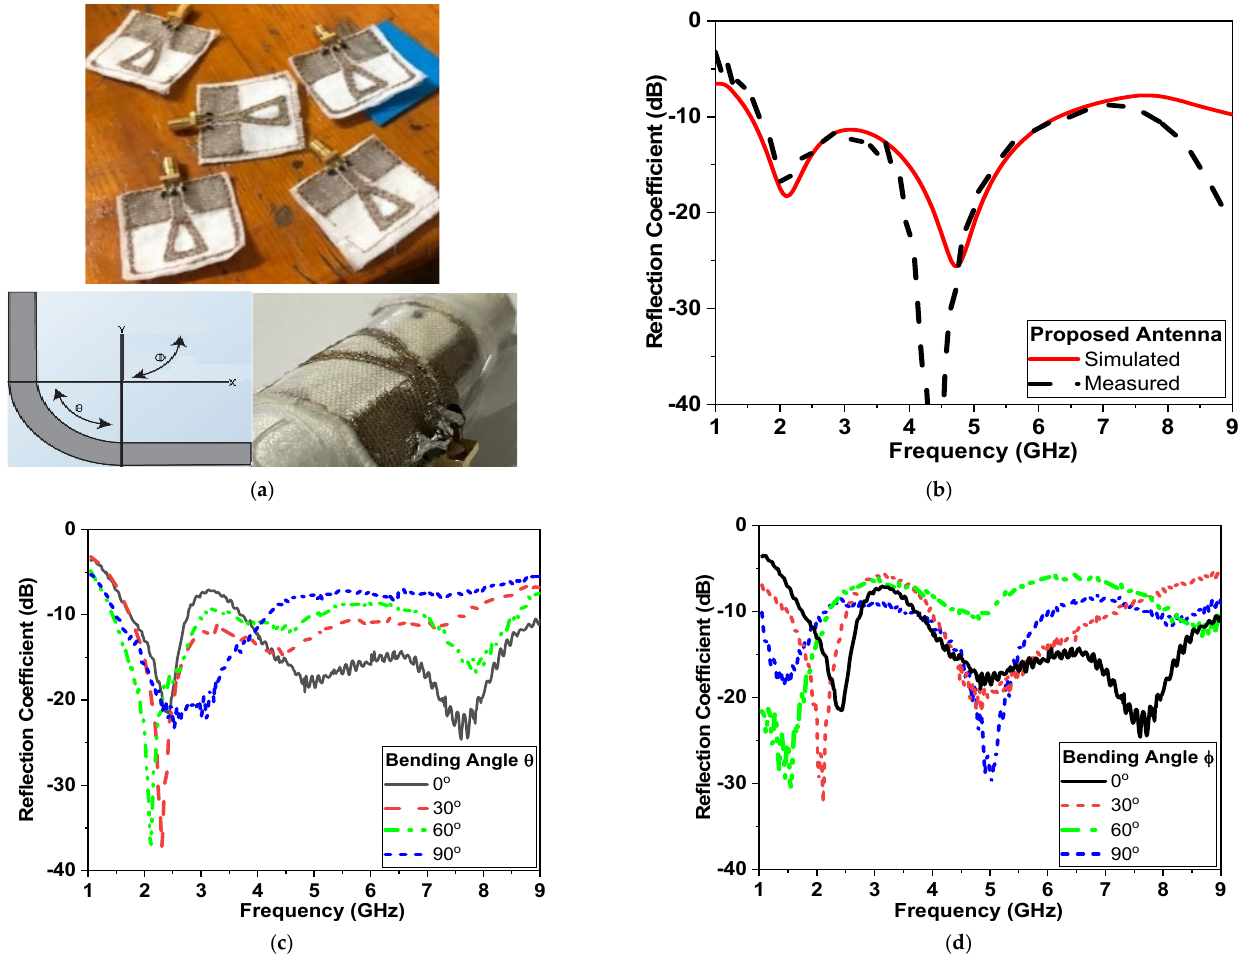
Figure 18. ( a ) The fabricated textile-based CPMS sensor, ( b ) Comparison of the CPMS sensor reflection coefficient between measured and simulated ( c ) Measured reflection coefficient of the CPMS sensor bending effect on θ o and ( d ) Reflection coefficient of the CPMS sensor bending effect on ϕ o .